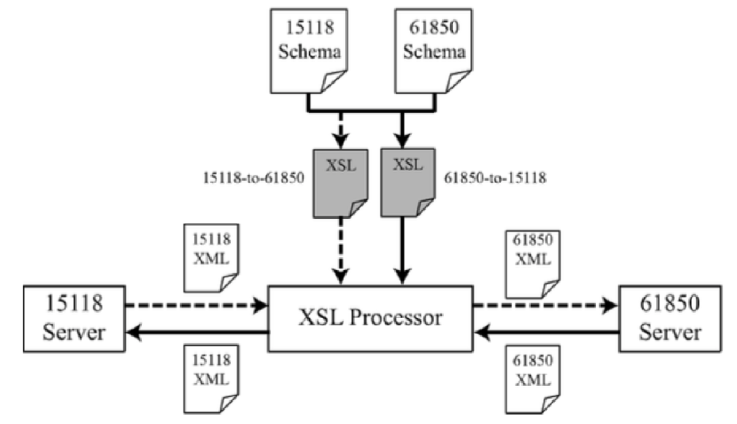
Figure 3. Charging procedure overview with relevant standards in